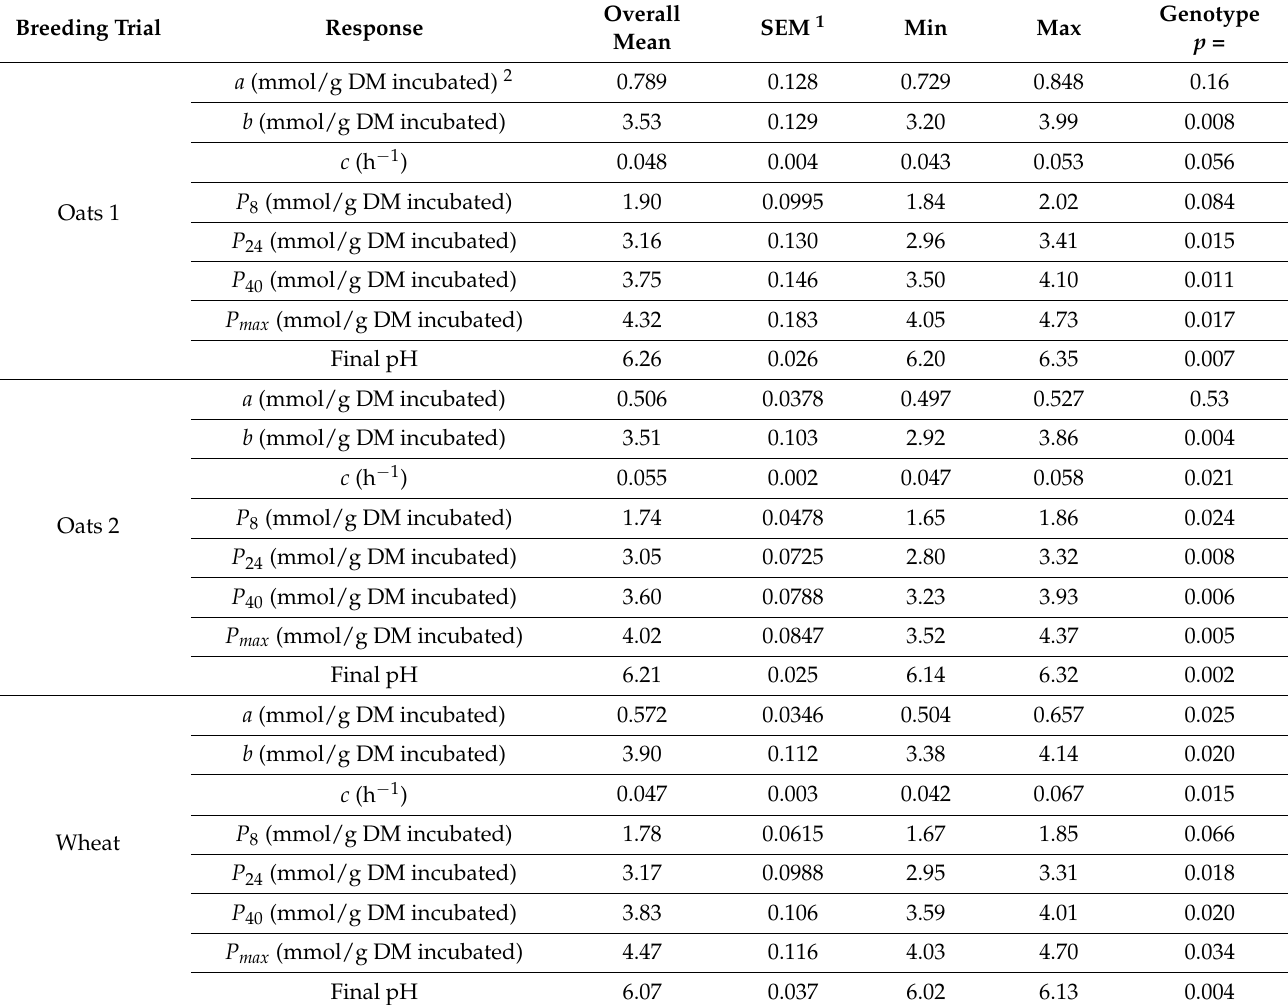
Table 2. Effect of the genotype of oats and wheat from three breeding trials (Oats 1, advanced breeding lines and commercial varieties; Oats 2, commercial and historical varieties; Wheat, advanced breeding lines and commercial varieties) on gas production parameters and final pH of straw incubated in in vitro rumen